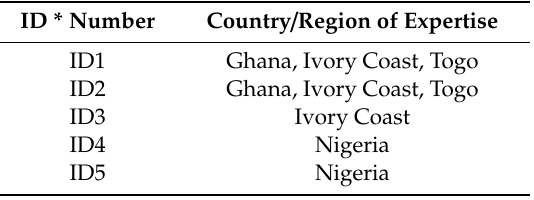
Table 2. Identification numbers assigned to expert